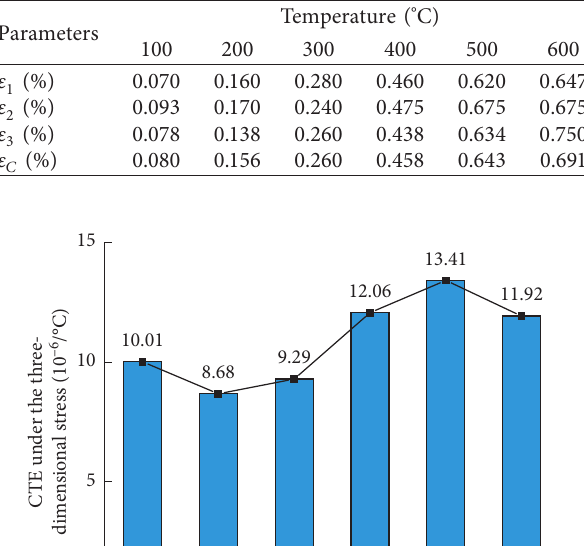
Figure 5: CTE of concrete under three-dimensional stress.